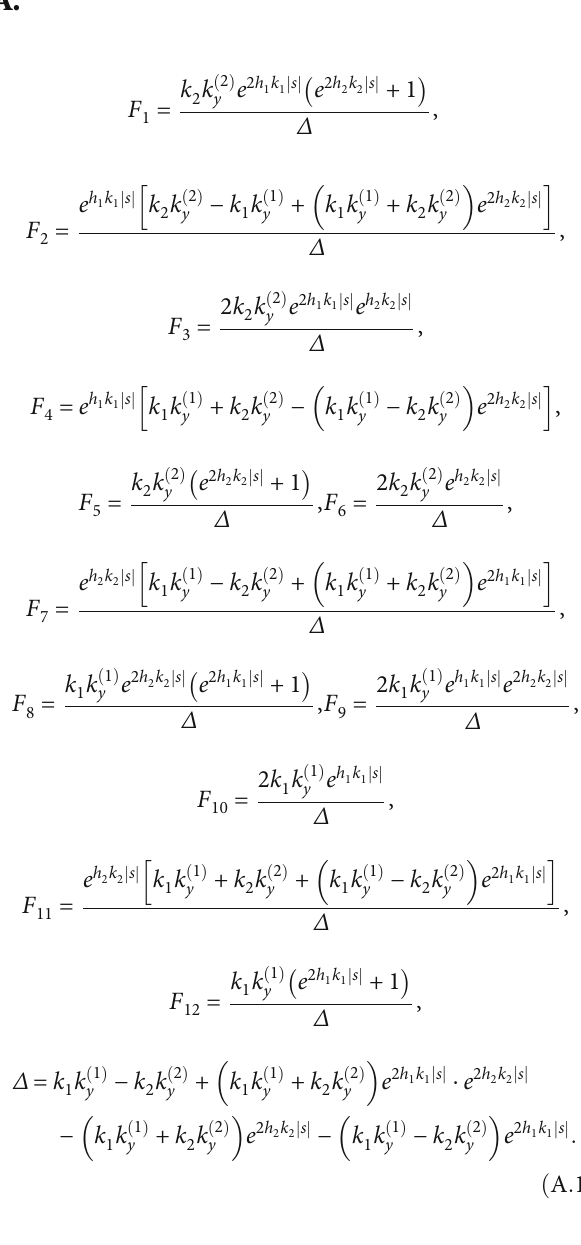
on mode II thermal stress intensity factor 2 / h . 1 2